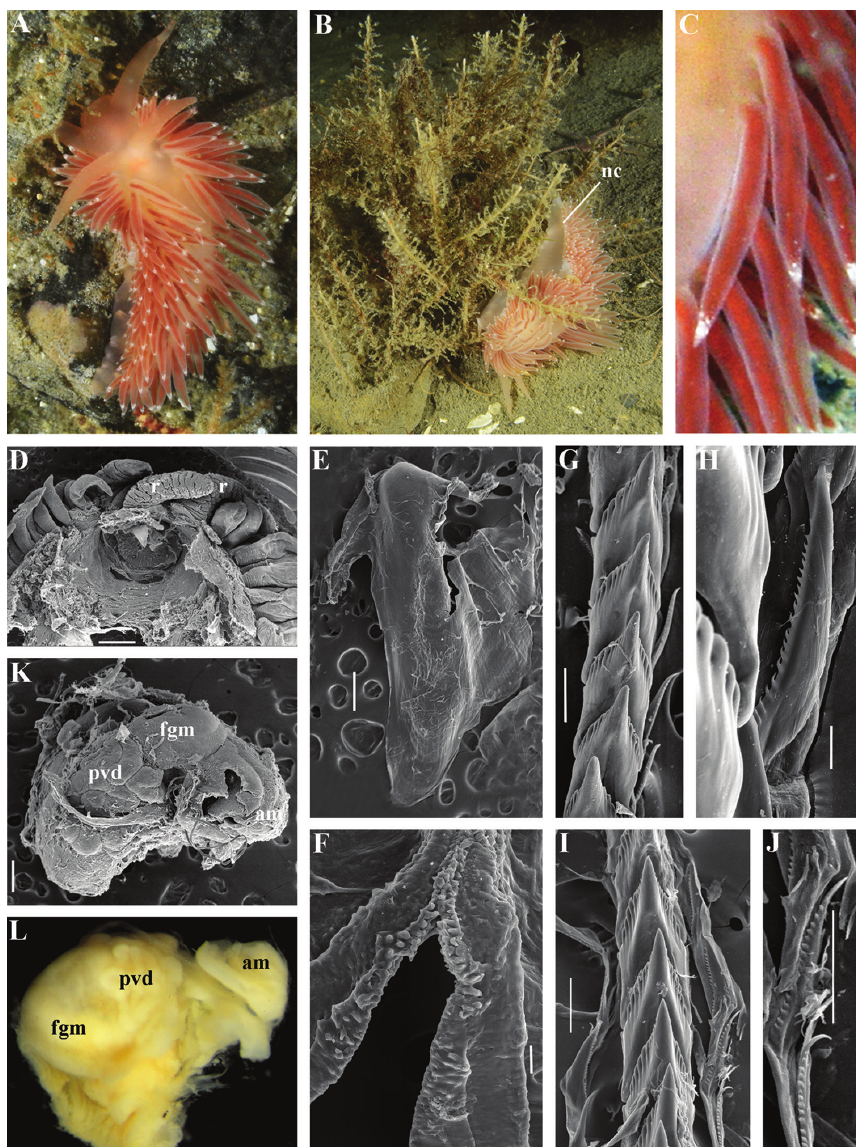
Figure 13. Ziminella circapolaris sp. n.: Barents Sea, Franz-Josef Land: A living animal, dorsal view ZMMU Op-482 B living animal on a hydroid colony ZMMU Op-483, 12 mm in fixed length C same, details of cerata D dissected anterior part (pharynx removed) and rhinophores, SEM E jaw, SEM F details of masticatory process of jaw, SEM G radular teeth, posterior part, SEM ZMMU Op-482 H lateral tooth, close up, SEM ZMMU Op-482 I radular teeth, posterior part, SEM ZMMU Op-483 J lateral tooth, close up, SEM ZMMU Op-483 K reproductive system, SEM ZMMU Op-483 L reproductive system, light microscopy. Abbreviations: am ampulla fgm female gland mass nc continuous notal edge pvd prostatic vas deferens r rhinophores. Scale bars: D = 1 mm; E, K = 300 μm; F, H = 30 μm; G, I, J = 100 μm. Photos of living specimens by O.V. Savinkin, other photos and SEM images by A.V.